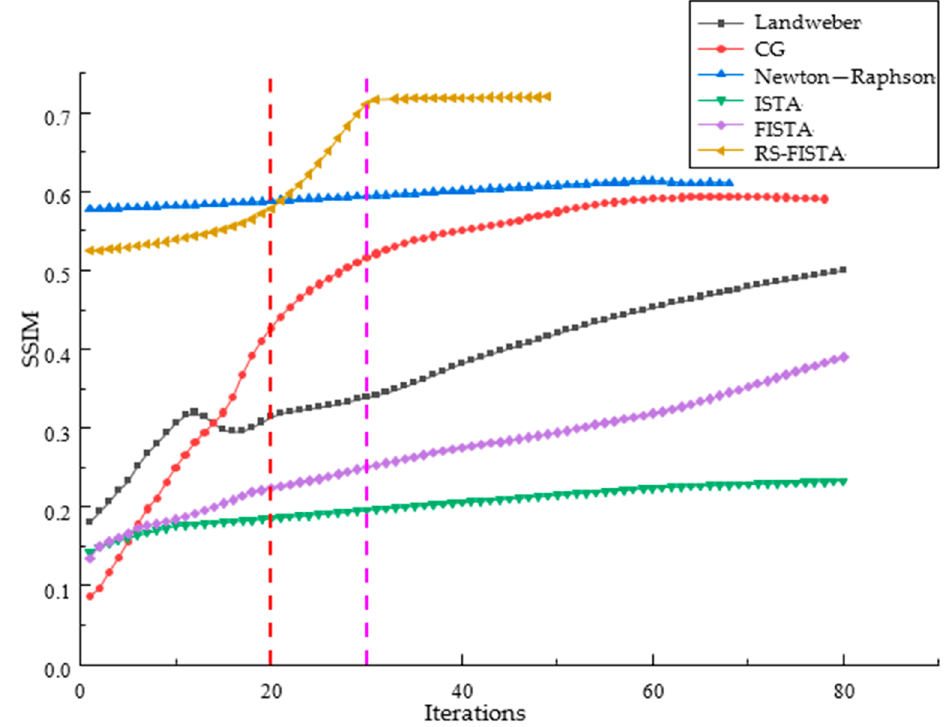
Figure 6. The SSIM variation with iterations of different methods (Use red and purple vertical lines to divide the number of iterations into three zones).